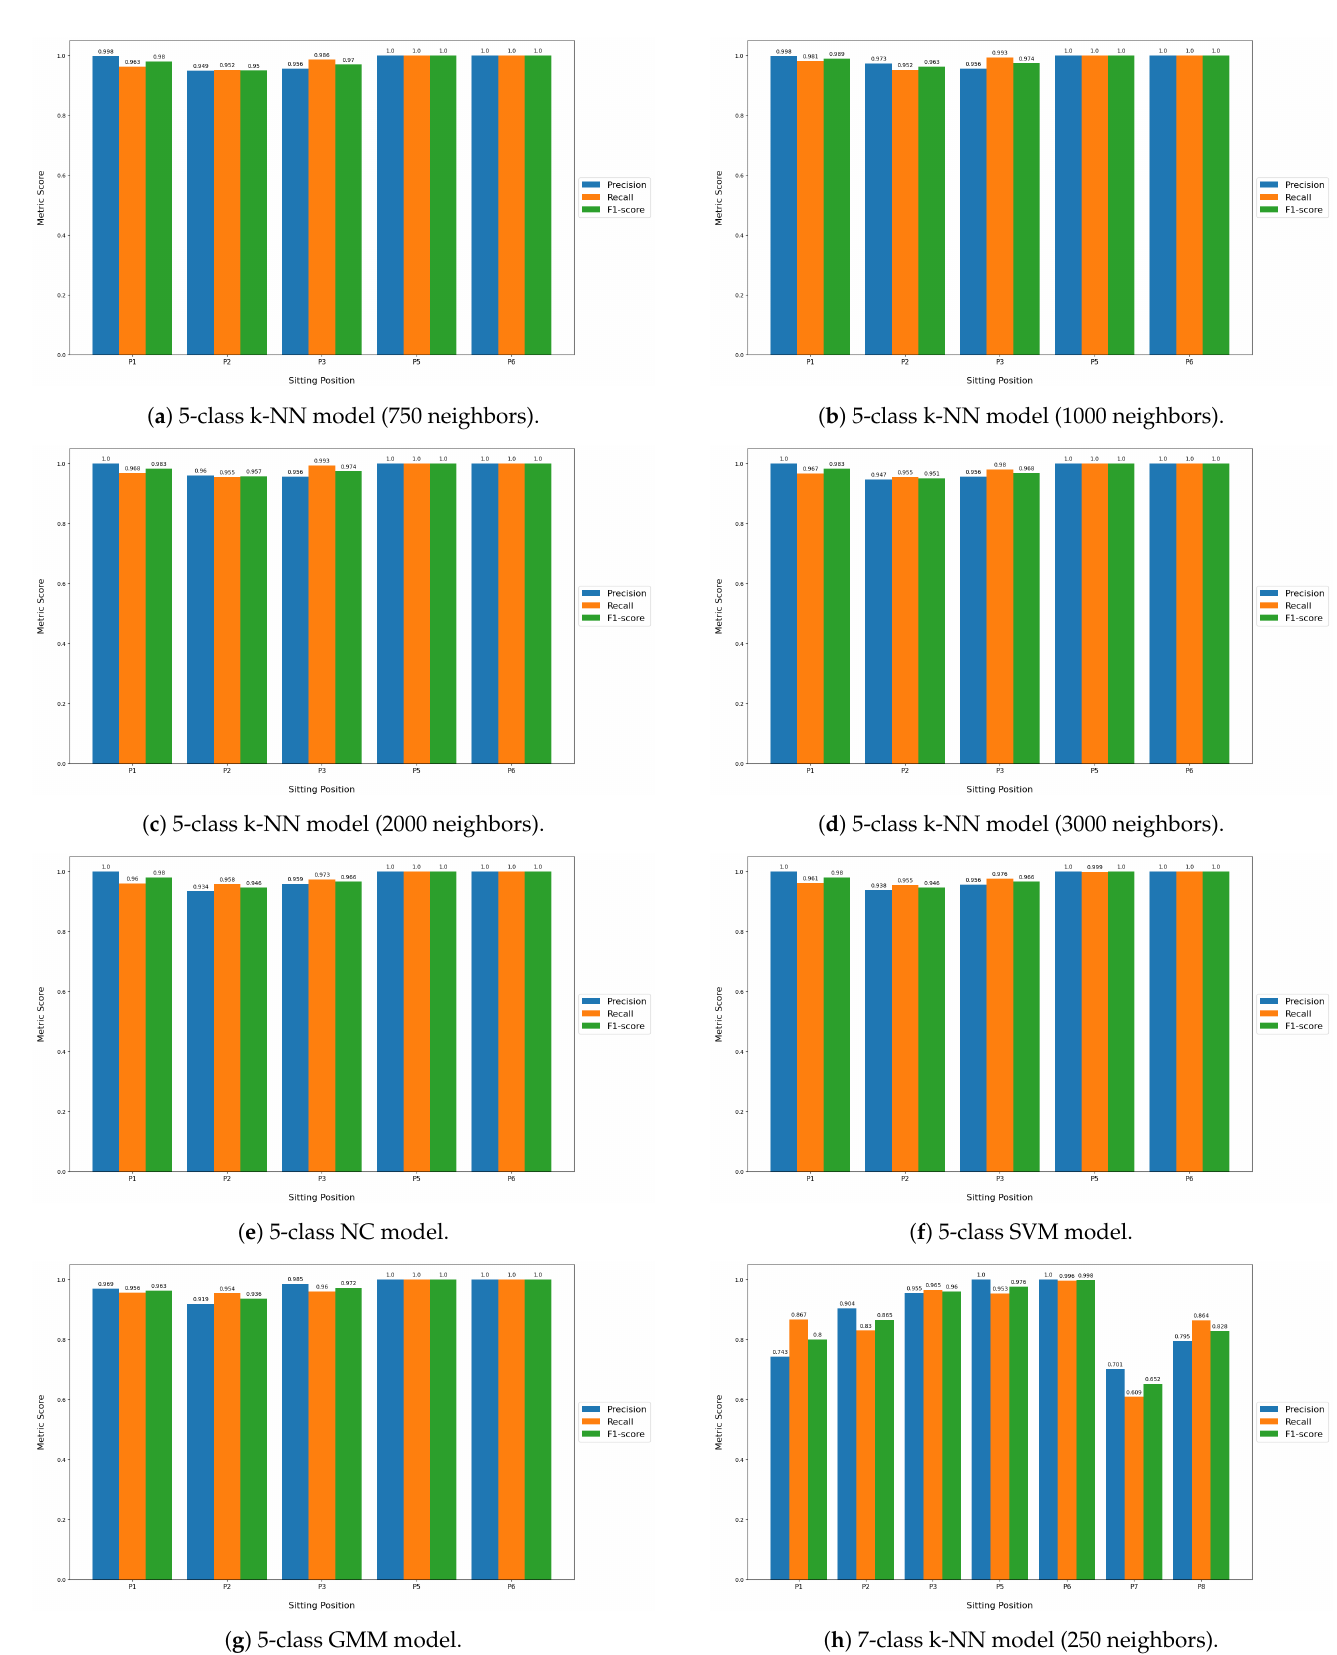
Figure A2. Label-wise precision, recall and F1-score values obtained for each classifier